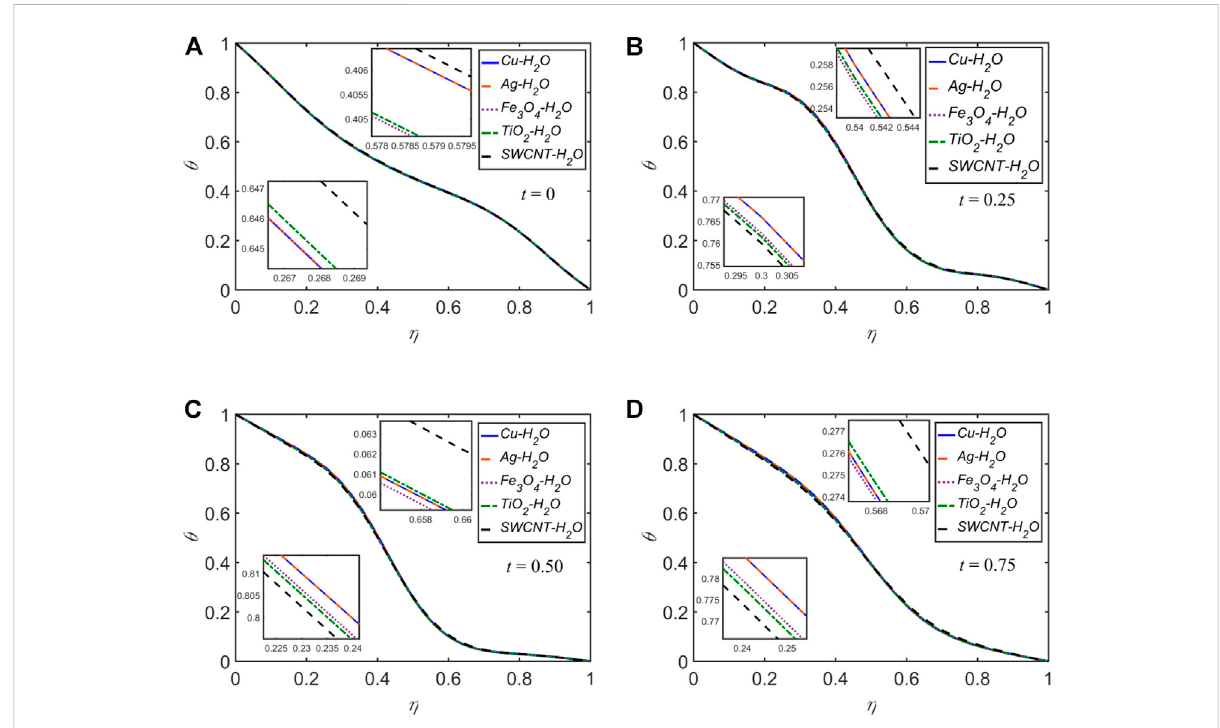
For validation, the present results for the pulsatile fl ow condition are compared with those obtained by Bandyopadhyay and Layek (2012) withouttheheateffect.Figure2showsagood agreementof the present results, speci fi cally for the wall shear stress (WSS), with (Bandyopadhyay and Layek, 2012) for M (cid:2) 5 , and 10 at t (cid:2) 0 . 25. The effects of varying the volume fraction on the wall shear stresses (WSS) at the upper wall are computed for ϕ (cid:2) 0 , 0 . 01 , 0 . 02 , 0 . 03 with M (cid:2) 5, St (cid:2) 0 . 02, Pr (cid:2) 1, and Rd (cid:2) 0 . 2 of the fi ve NFs. The results are shown in Figure 3 at x (cid:2) 0 and t (cid:2) 0 . 25. The WSS is maximum at t (cid:2) 0 . 25 as the fl ow rate is maximum. The WSS decreases for SWCNT - H 2 O , TiO 2 - H 2 O , and Fe 3 O 4 - H 2 O on increasing ϕ , whereas the WSS slightly increases for Cu - H 2 O and Ag - H 2 O on increasing ϕ . The velocity and temperature pro fi les for each of the fi ve NFs for M (cid:2) 0 , 5 , 10 , 15 are shown in Figures 4, 5 and Figures 6, 7, respectively, by setting the other parameters as St (cid:2) 0 . 02, Pr (cid:2) 1, Rd (cid:2) 0 . 2 , and ϕ (cid:2) 0 . 02. The slope/gradient of the velocity pro fi le rises with rising values of M , i.e., the viscous boundary layer declines with rising values of M . In Figure 4, u pro fi les at x (cid:2) 0 and t (cid:2) 0 . 25 are shown. It has been noted that the peak value of u rises with M and exhibits a parabolic pro fi le at t (cid:2) 0 . 25. The velocity reaches its maximum at the middle of the constriction. SWCNT -based NF attains the peak value of the velocity higher than that of the other NFs. In Figure 5, u pro fi les at x (cid:2) 2 and t (cid:2) 0 . 25 are shown. The pro fi les are not parabolic as some